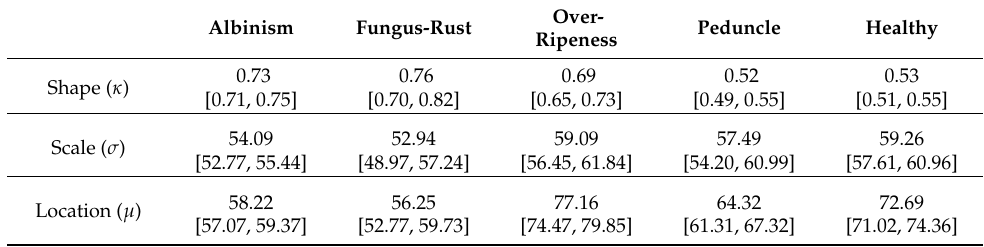
Table 3. Analysis using the generalized extreme value distribution. The table shows the average thresholds and the learning bounds of each class.